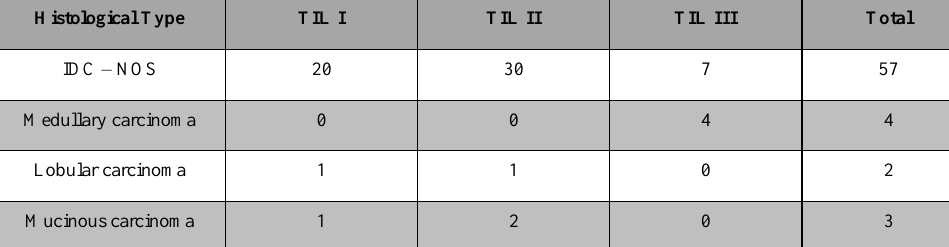
Table 4. TIL Score correlation with the histological type of breast carcinoma.